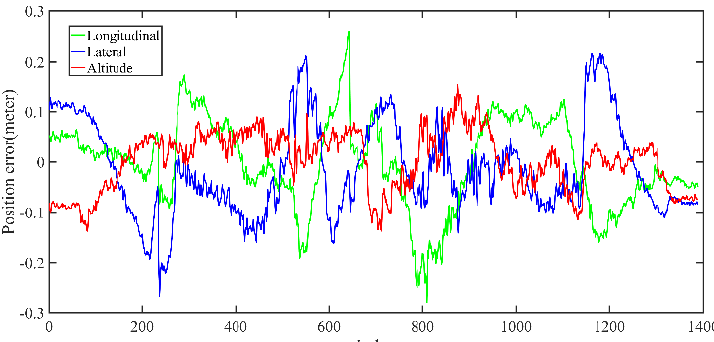
Figure 22. Field test NO.1. One lap under normal driving scenario localization error in longitudinal, lateral, and altitude directions, respectively; the localization error is at the centimeter level.